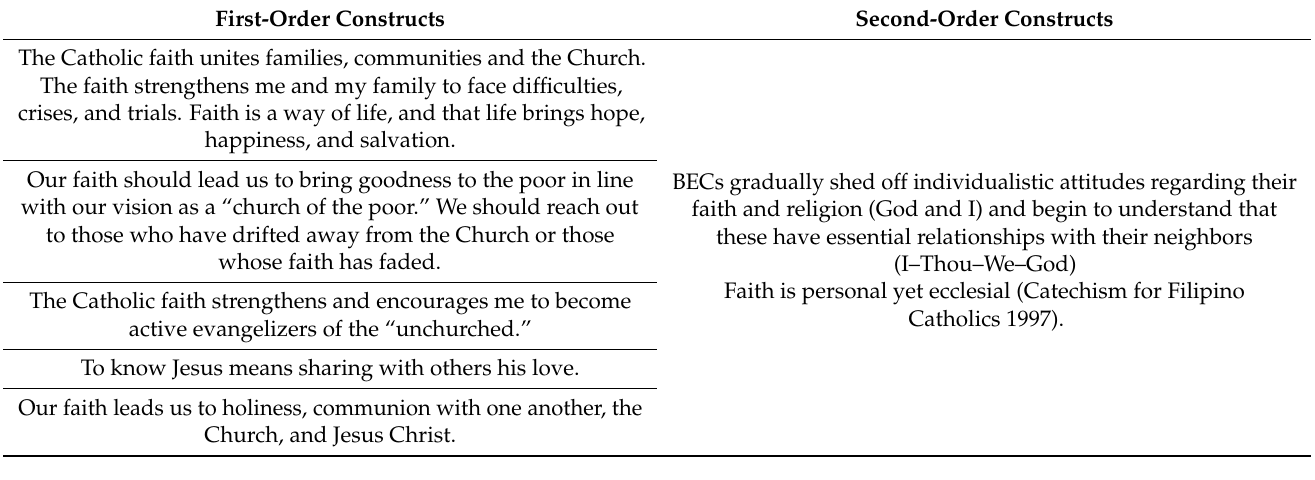
Table 1. Why is the Catholic faith important to you?